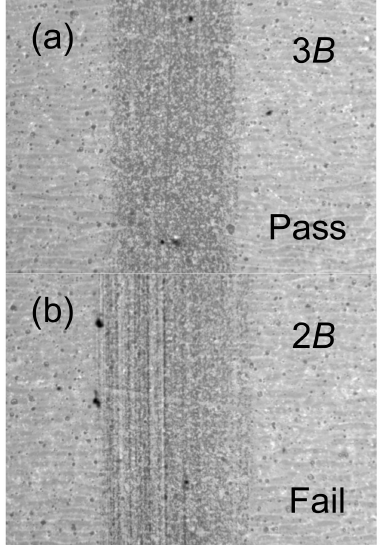
Figure 3. Characteristic optical microscope digital photographs (magnification 150 × ) of PETMP-TTT coatings after pencil hardness test: ( a ) 3B passed test and ( b ) 2B failed